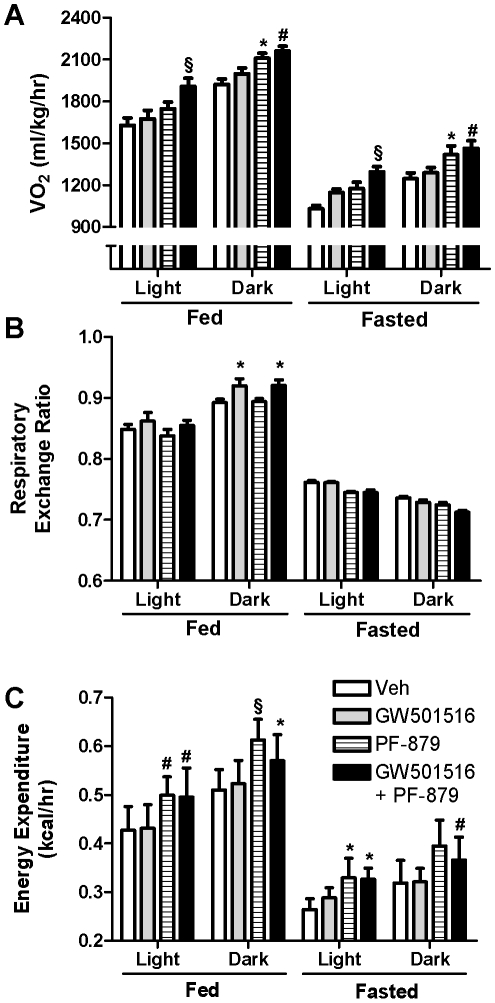
Myostatin inhibition increases oxygen consumption and energy expenditure in ob/ob mice.Indirect calorimetry was performed following 6 weeks administration of vehicle (veh), GW501516, PF-879, or GW501516 in combination with PF-879 to quantify oxygen consumption (VO2) (A) and carbon dioxide production to calculate the respiratory exchange ratio (B) and energy expenditure (C) in ob/ob mice. Data are represented as mean +/− SEM (n = 8/group). *, # and § represent p<0.05, 0.01 and 0.001, respectively.